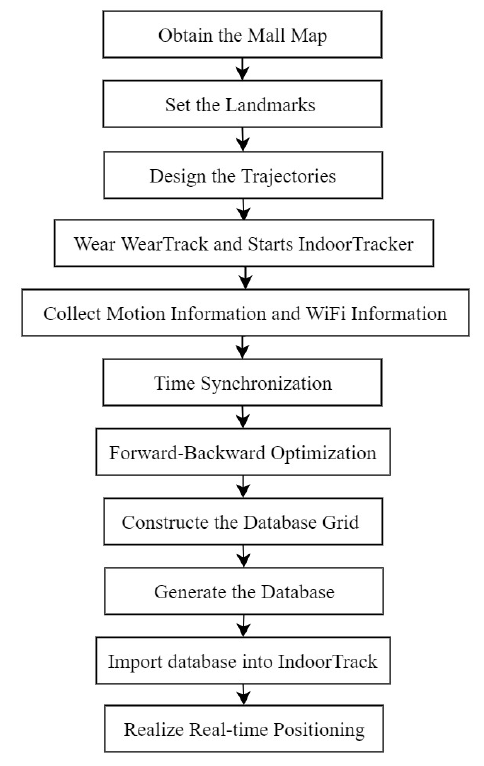
Figure 4 . The Overall Process of the Test Process